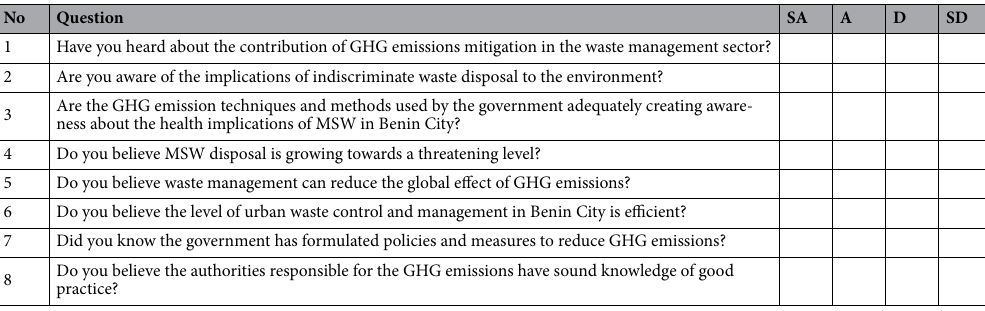
Table 6. Key questions asked to respondents using a four-point Likert scale. SA = strongly agree (1), A = agree (2), D = disagree (3), and SD = strongly disagree